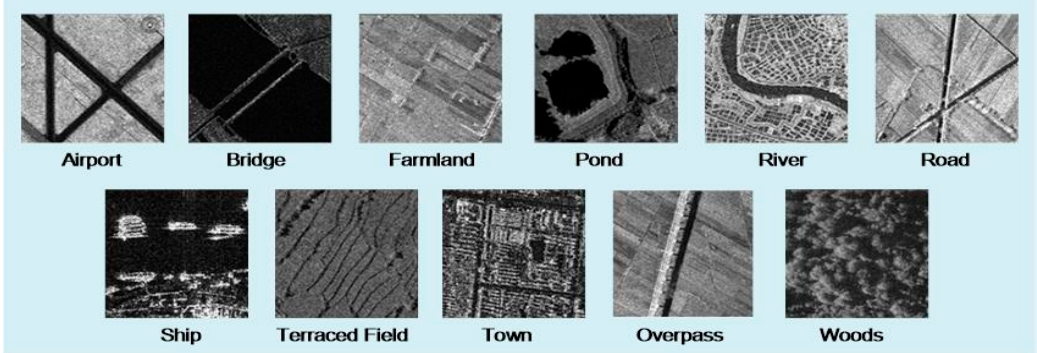
Figure 5. Examples of the 11 types of scenes.